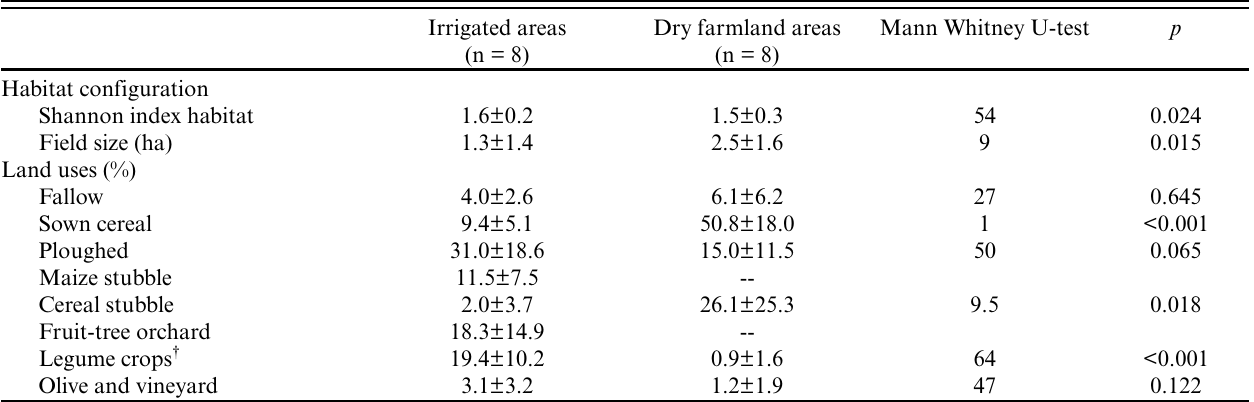
Table 1 . Averaged (±SD) habitat composition and configuration of the study sites grouped by irrigated and dry farmland areas. Irrigated